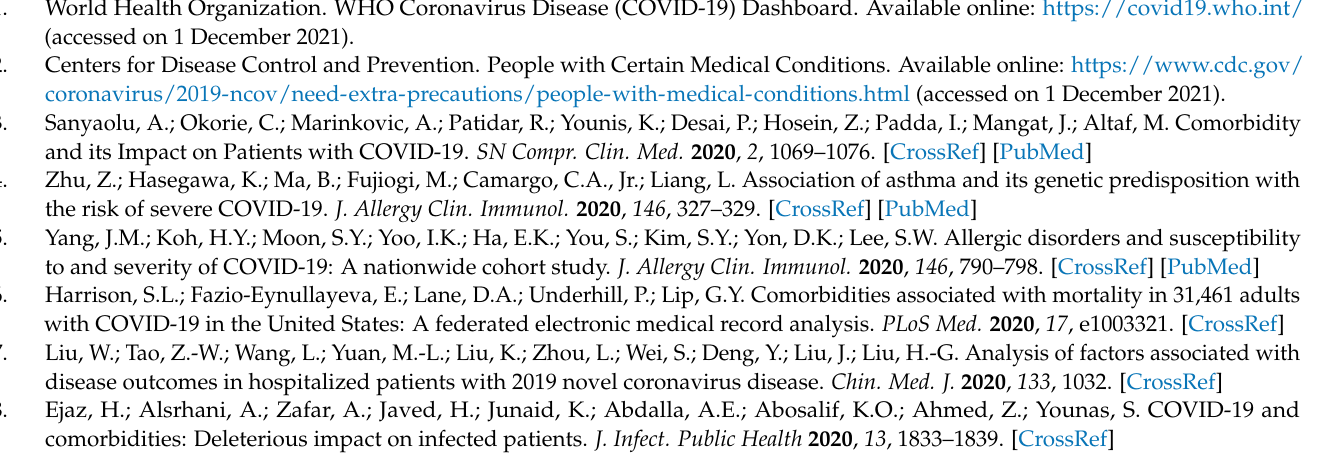
and (b) Theophylline, Figure S2: DSC thermograms of the FAV-THP cocrystal produced by rotary evaporation and spray drying after stability test, Figure S3: Water sorption isotherms at 25 ◦ C of the FAV-THP cocrystals produced by different methods, Figure S4: Temperature-composition phase diagram of the FAV-THP cocrystal system, Figure S5: TGA profiles of the FAV-THP cocrystal system, Figure S6: 2D contour plots for the (A) MMAD, (B) FPF, (C) EF, and (D) CI as projections of the total solute concentration (x-axis) and the feed pump rate (y-axis), holding a high level atomizing gas flow, Figure S7: 3D surface plots for the (A) MMAD, (B) FPF, (C) EF, and (D) CI at high level atomizing gas flow, Figure S8: Scanning electron micrographs of different spray-dried cocrystal dry powder formulations at 5000 × magnification, Figure S9: PXRD (a) and DSC (b) profiles of different spray-dried FAV-THP formulations, Table S1: Experimental outlet temperatures resulted in the DOE, Table S2: The powder dispersion was performed at various flow rates to obtain 4 L passing air drawn into the next generation impactor (NGI) with designated pressure drops, Table S3: Equilibrium solubilities of coformers and cocrystal at 20 ◦ C, Table S4: Crystal data and structure refinement for THP:FAV, Table S5: Atomic coordinates ( × 10 4 ) and equivalent isotropic displacement parameters (Å 2 × 10 3 ) for THP:FAV, Table S6: Bond lengths [Å] and angles [ ◦ ] for THP:FAV, Table S7: Anisotropic displacement parameters (Å 2 × 10 3 ) for THP:FAV, Table S8: Hydrogen coordinates ( × 10 4 ) and isotropic displacement parameters (Å 2 × 10 3 ) for THP:FAV, Table S9: Hydrogen bonds